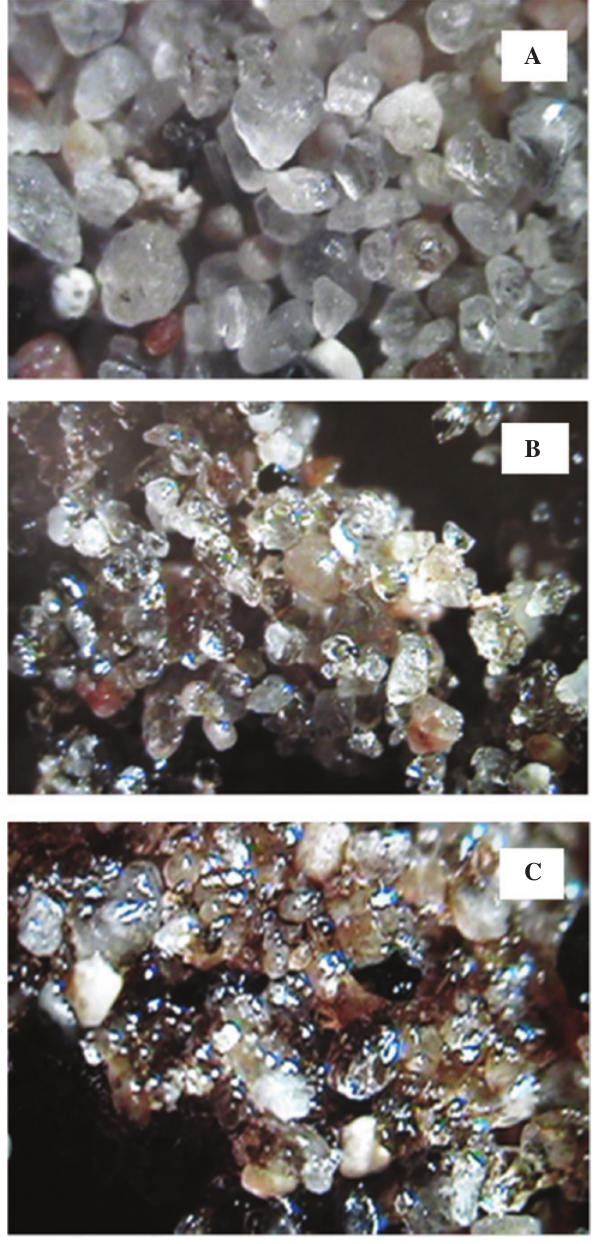
= 0% (dry sand), (B) S-CaL-W mix l = 14%. l